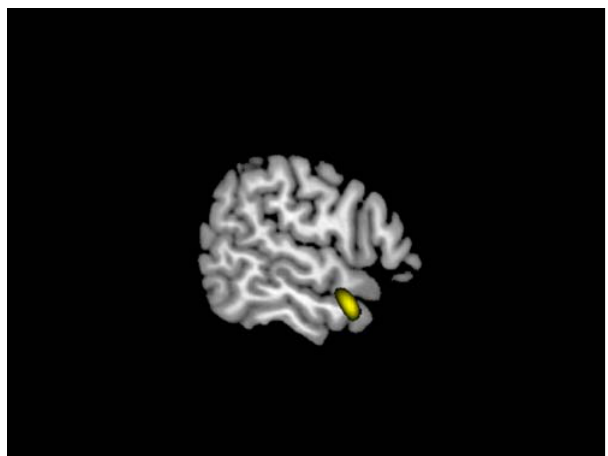
Figure 1. Experiencing an intimate relationship with God (PC1) positively correlated with cortical volume at the R middle temporal gyrus (MTG), BA 21, extending to the temporal pole. Threshold was set to p , 0.001 uncorrected for visualization.